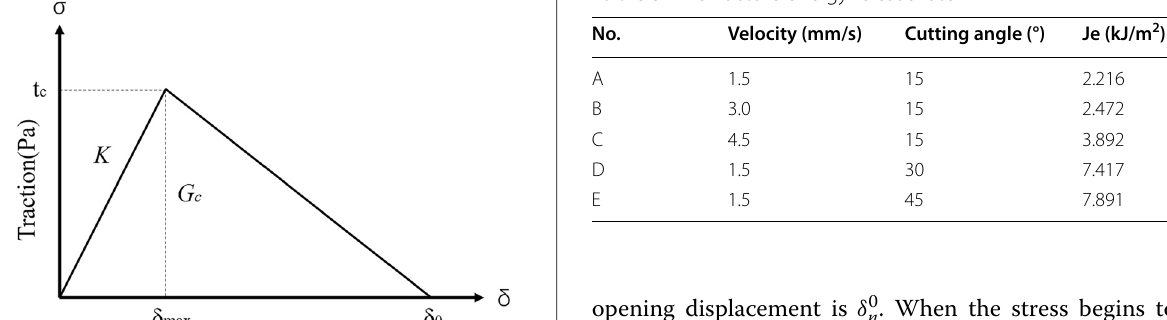
Table 3 The fracture energy release